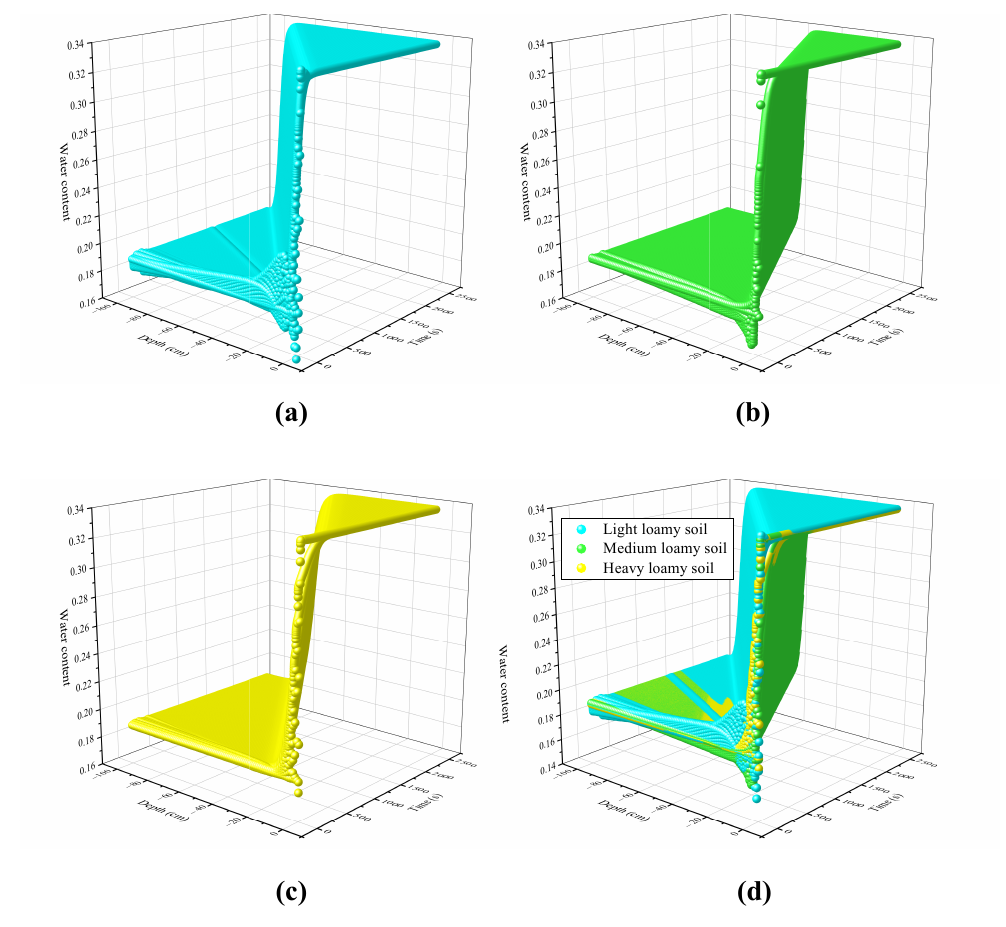
Figure 9. Three-dimensional point of water infiltration processes in different types of soil, ( a ) is for light-loamy soil, ( b ) is for medium-loamy soil, ( c ) is for heavy-loamy soil, ( d ) is for the soil of three